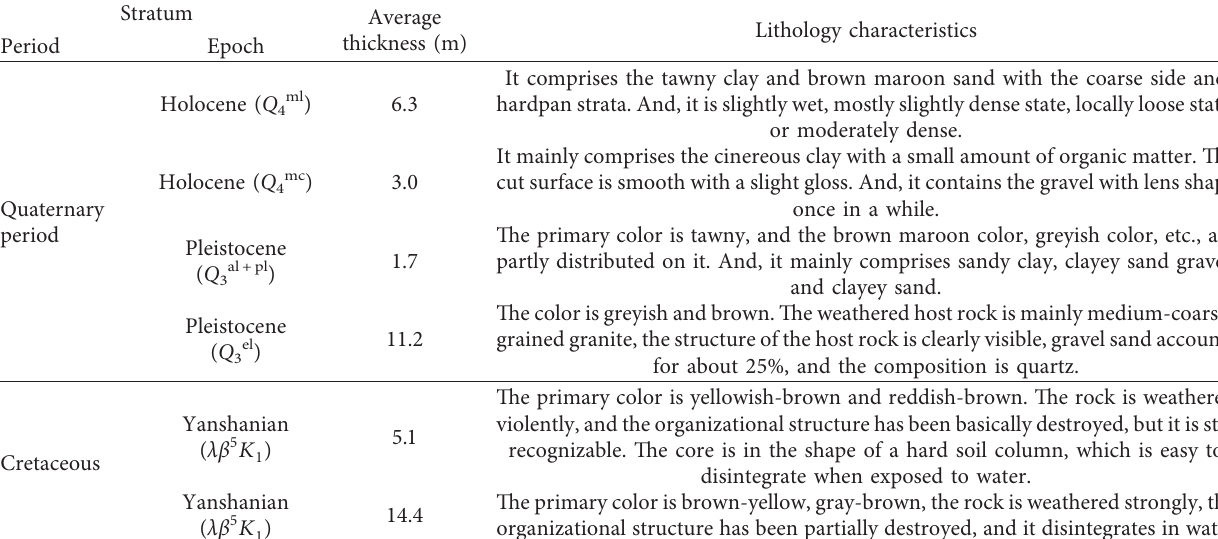
Figure 2: Diagram of the foundation pit. (a) Diagram of monitoring points. (b) Diagram of foundation pit study area. Table 1: The information of soil